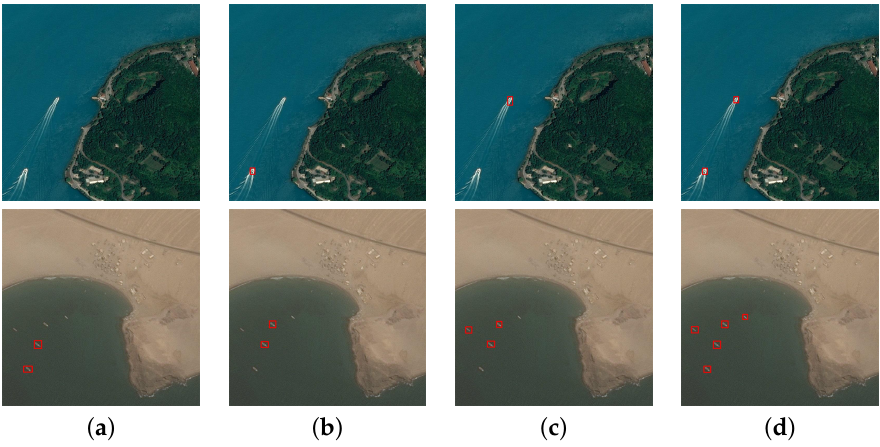
Figure 9. Detection results of small ships with different algorithms: ( a ) method from [40];